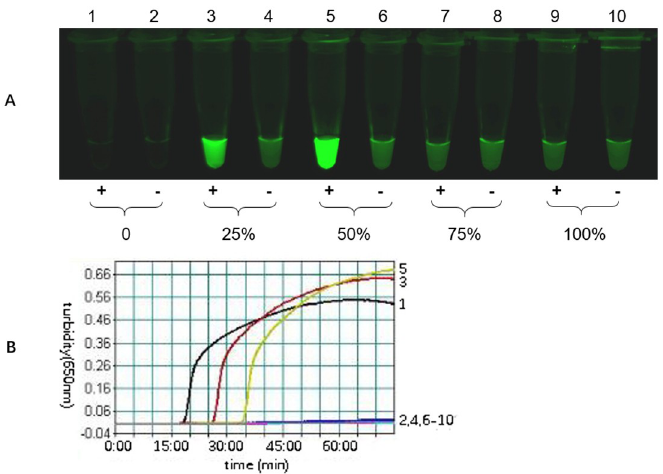
Fig 2. The effect of the ratio of FD-FIP composite probe to unlabeled primer on FMDV amplification. The mLAMP reaction was optimized by using FMDV-specific primers and an FD-FIP composite probe (labeled with FAM and BHQ1). The products were imaged by using the 520 nm channel (A), and the turbidity curve was generated by a real-time turbidimeter (B). The total amount of FIP in each reaction was maintained at 0.8 μ M and composed of various ratios of FD-FIP to unlabeled FIP as follows: 1: FD-FIP: unlabeled FIP = 0; 3: 25%; 5: 50%; 7: 75%; 9: 100%, 2, 4, 6, 8, 10 were the negative controls for the corresponding proportions. With the increase in the FD-FIP ratio, the inhibition became more severe with a slower amplification time. At FD-FIP concentrations equal to or higher than 75%, the turbidity curve and fluorescence increase were not observed, suggesting that the reaction was completely inhibited at these concentrations. An equimolar ratio (50%) was used to balance the fluorescence signal and amplification rate for FMDV amplification in the mLAMP